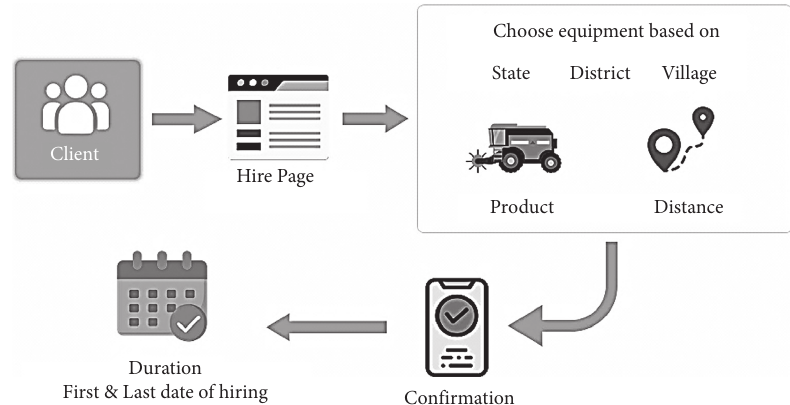
Figure 11: Distance and cost